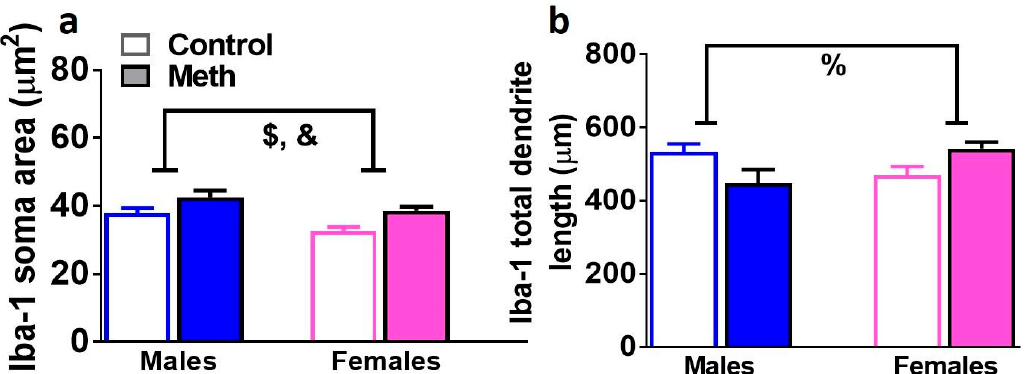
Figure 6. Microglial cells are distinctly altered in male and female rats. 3D Sholl analysis of Iba-1 cells were performed to determine the soma area and total dendrite length of each cell. ( a , b ) Quantitative analysis of cell soma area and length of processes of Iba-1 cells. n = 6–12 males, n = 6–13 females. Data shown are represented as the mean ± SEM. %, sex × reinstatement interaction; &, main effect of reinstatement; $, main effect of sex by two-way ANOVA.